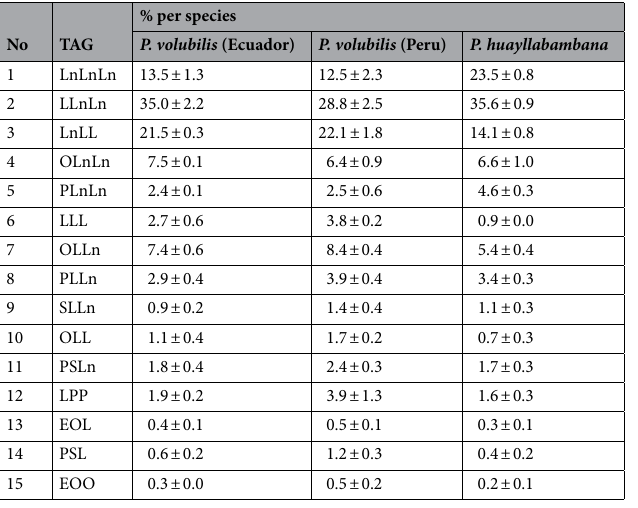
Table 1. Percentages of different TAGs in Plukenetia species and cultivars, n = 3 (except P. volubilis × P.carolis- vegae , n = 2). E, eicosanoic acid (C20:0); L, linoleic acid (C18:2); Ln, α-linolenic acid (C18:3); O, oleic acid (C18:1); P, palmitic acid (C16:0); S, stearic acid